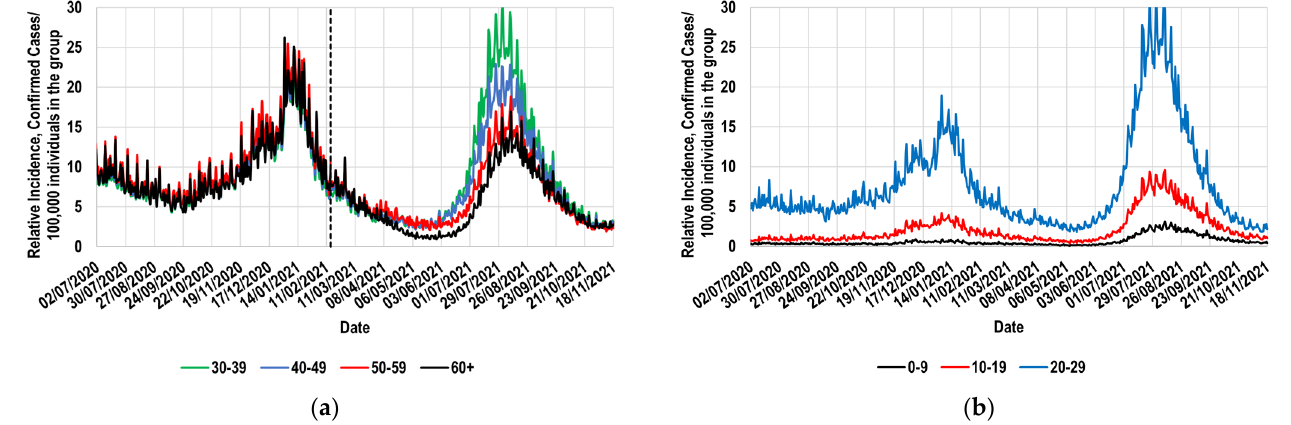
Figure 1. Relative incidence of confirmed cases by 100,000 individuals in the indicated group [41]. ( a ) Mexicans aged 30 years or older; ( b ) Mexicans aged 29 years or younger. Reference marker: Date at which the vaccination process of the 60+ group started (- - -)